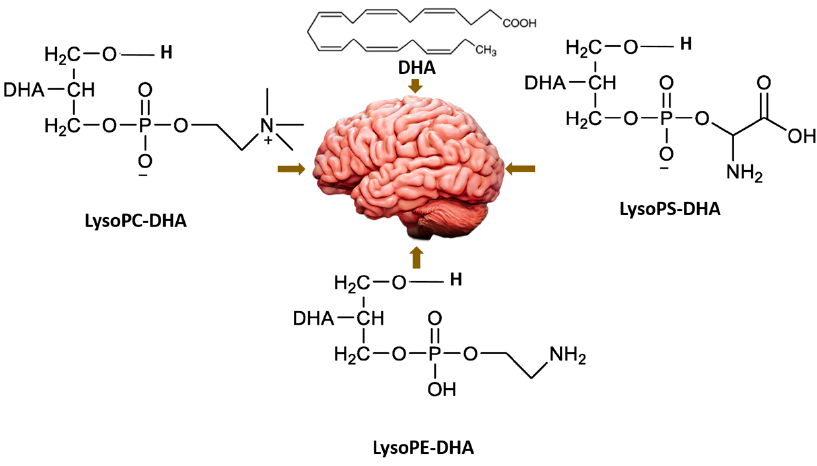
Figure 18. Targeting the brain with different DHA forms: free DHA, LysoPC-DHA, LysoPE-DHA and LysoPS-DHA .